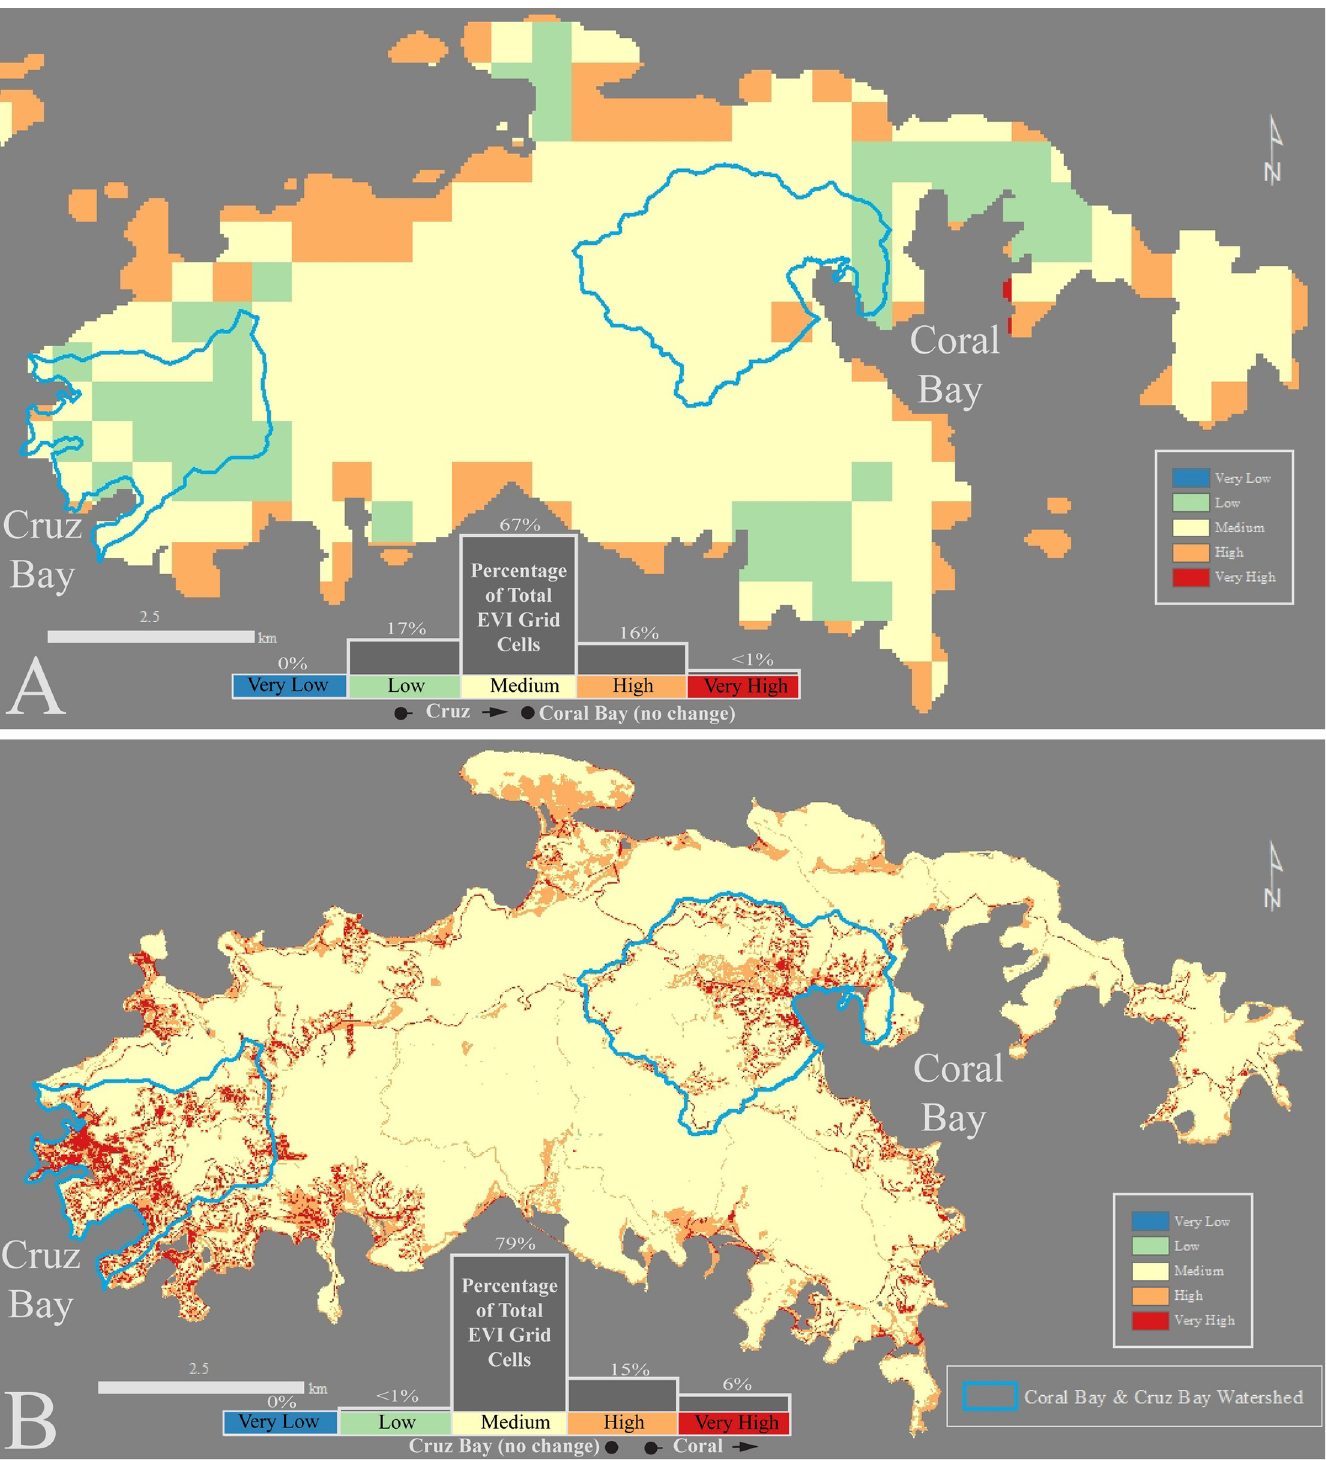
Fig 5. Improved resolution between the global EVI (A) and the EVI-STJ (B). Stark differences in vulnerability are revealed, concentrated in the two major communities of Cruz Bay and Coral bay.